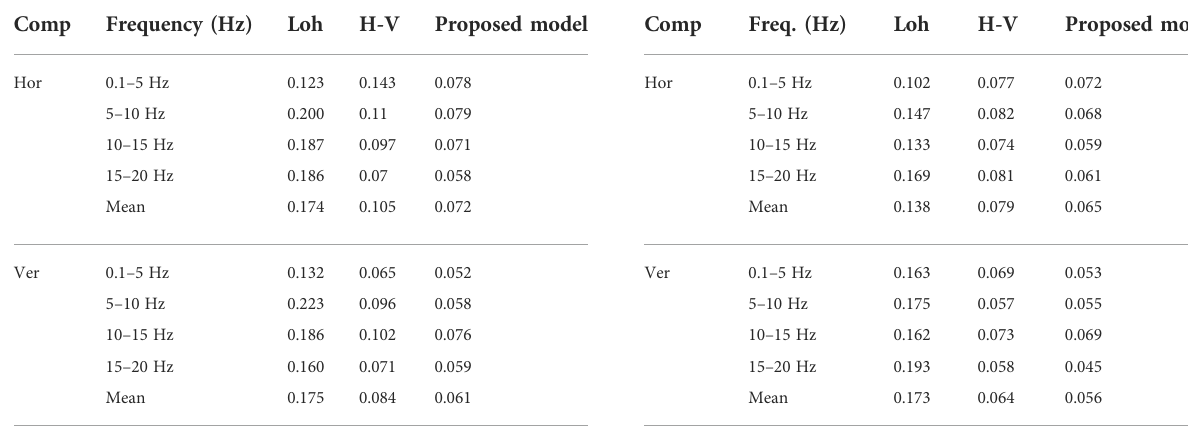
TABLE 5 RMSE of different models ’ fi tting results for the Yibin